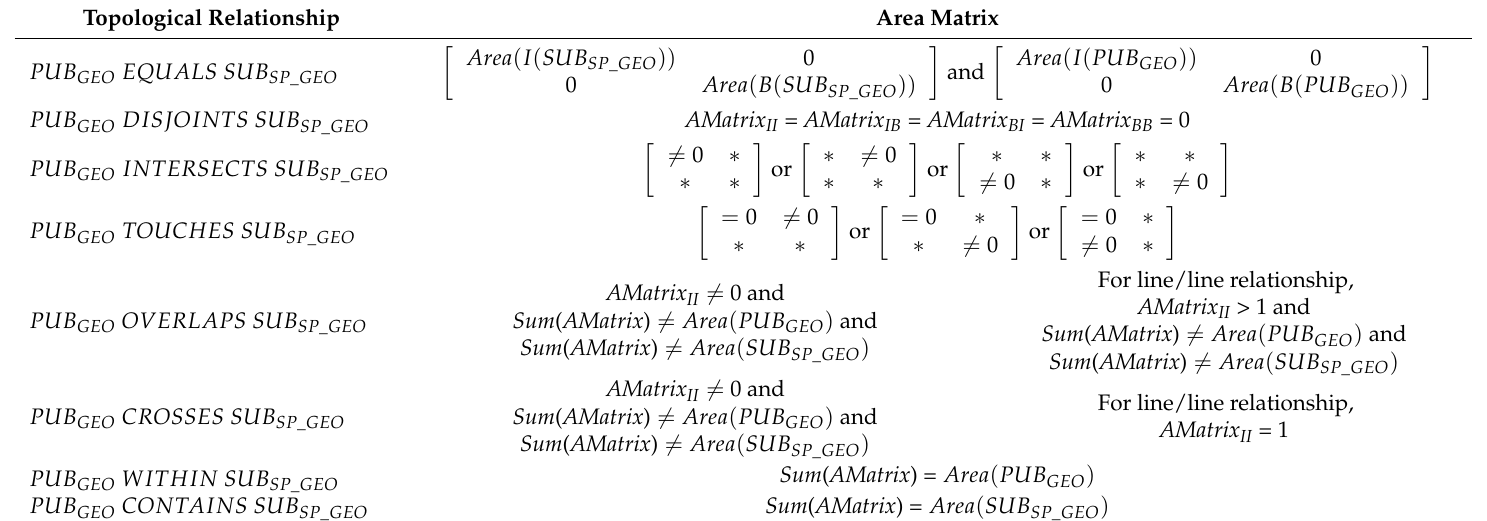
Table 2. The topological relationships and their corresponding area matrices. Topological